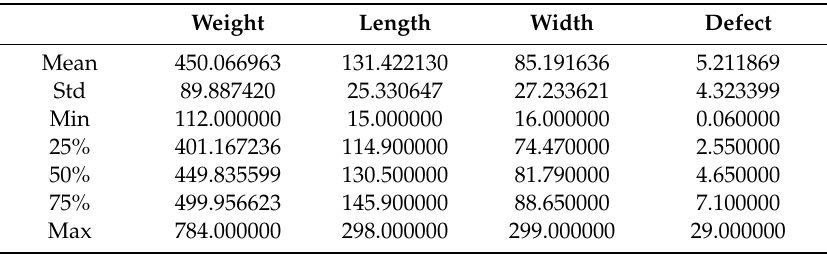
Table 3. Basic statistical information on the original data.